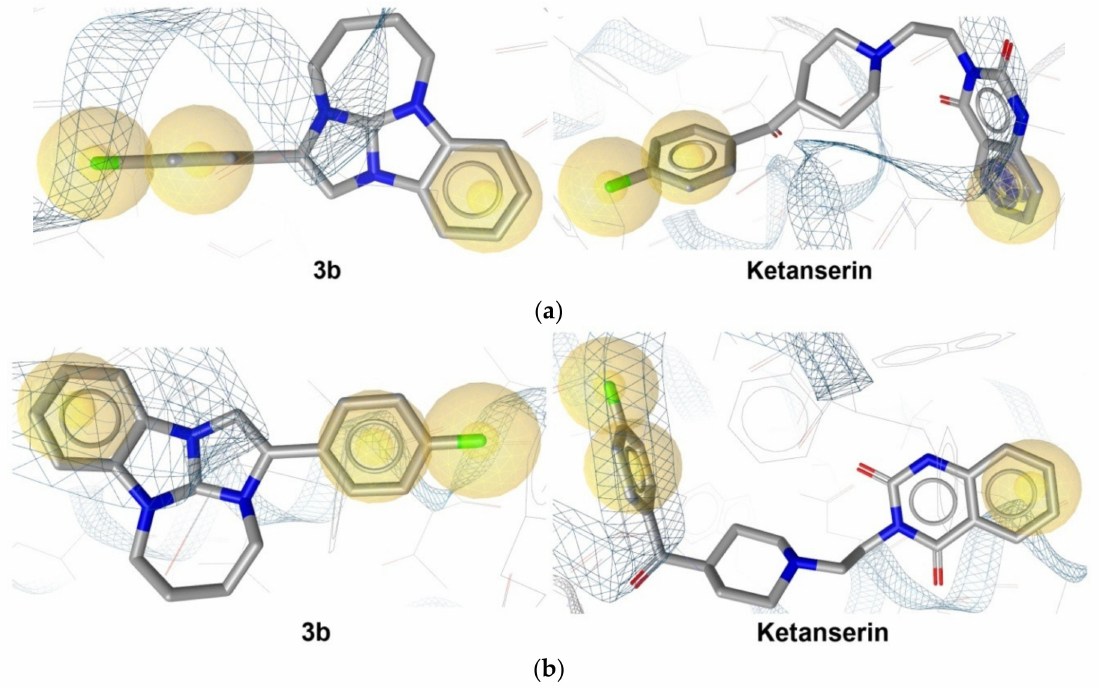
Figure 8. Arrangement of compounds at the sites of the 5-HT 2A receptor: ( a ) specific site; ( b ) allosteric